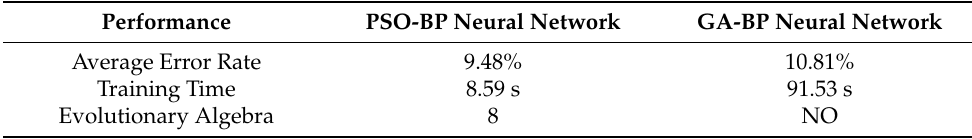
Table 9. Comparative analysis of algorithm